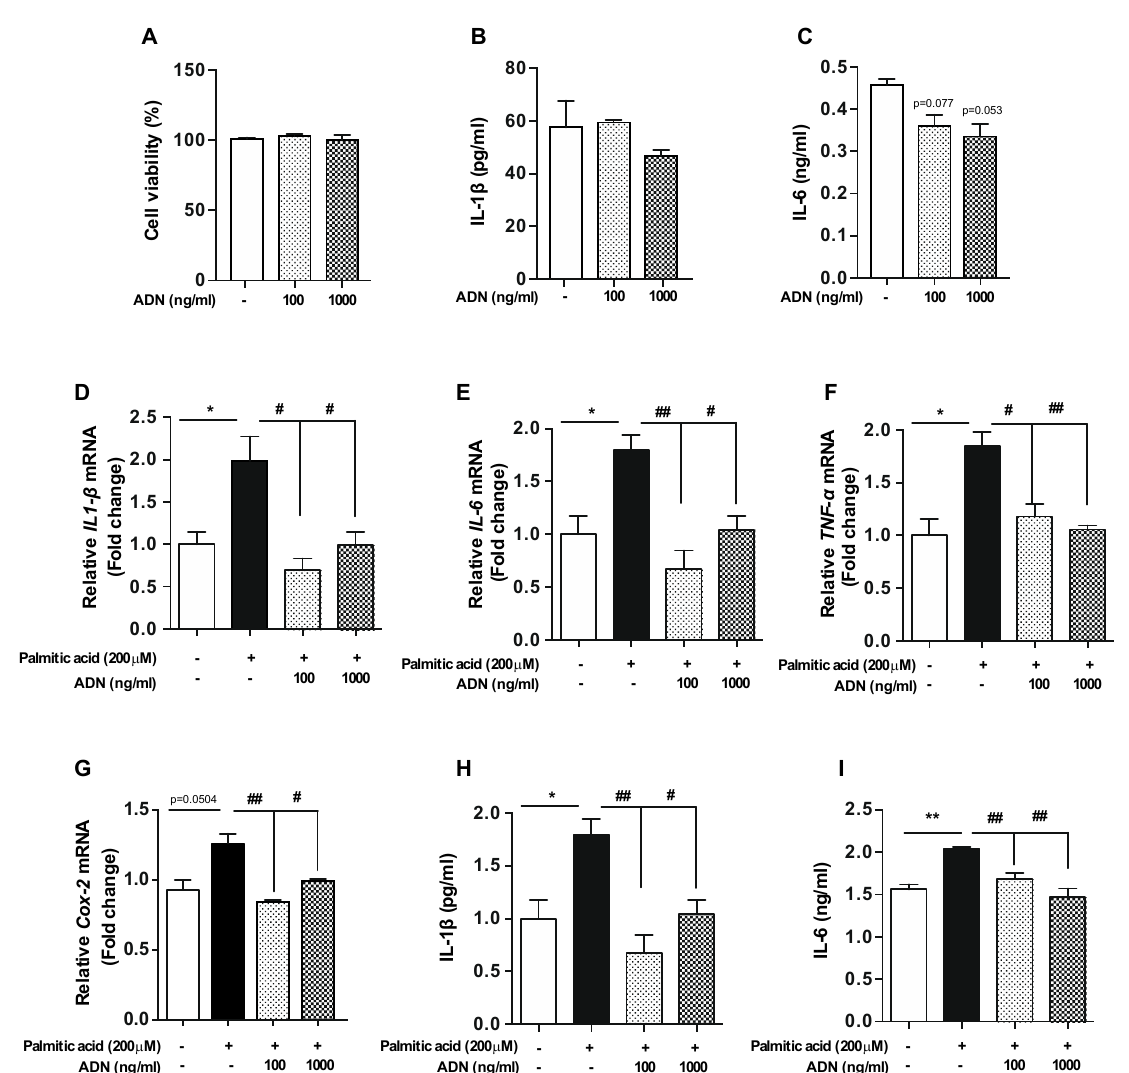
Figure 3. Adiponectin rescues the palmitic acid-induced inflammation in the microglial cell line. The BV-2 cells were seeded at a density of 5 × 10 5 cells / well and pretreated with adiponectin at indicated concentration for 1 h followed by palmitic acid (200 µ M) treatment for 4 h. Exogenous treatment of adiponectin did not change cell viability ( A ) or IL-1 β release ( B ), but reduced IL-6 secretion ( C ). The palmitic acid-induced elevations of IL-1 β ( D ), IL-6 ( E ) TNF- α ( F ) and Cox-2 ( G ) mRNA levels were reversed by adiponectin treatment in the BV-2 cells as determined by qPCR analysis. The palmitic acid-induced increase of IL-1 β ( H ) and IL-6 ( I ) cytokine release was reversed by adiponectin treatment in the BV-2 cells as determined by ELISA. Results are presented as mean ± SEM. * p < 0.05 and ** p < 0.01 for palmitic acid-treated group versus vehicle-treated group; # p < 0.05 and ## p < 0.01 for palmitic acid + adiponectin (ADN)-treated group versus palmitic acid-treated